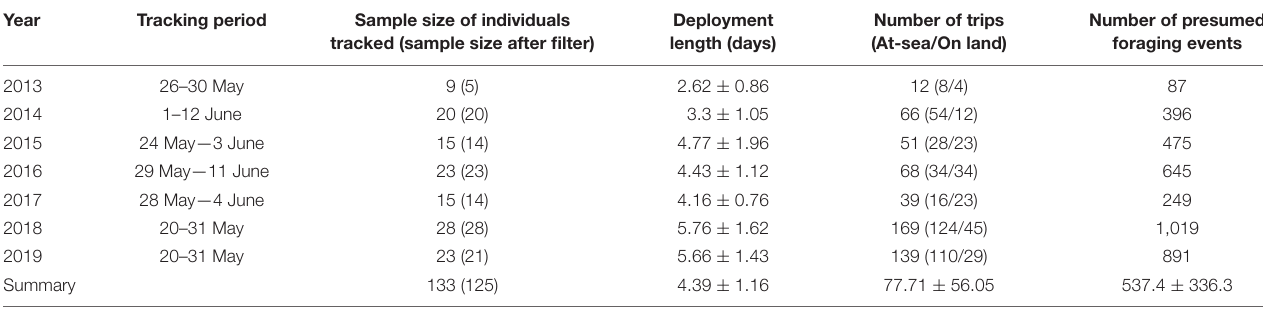
TABLE 1 | Summary of western gull tracking dates, sample size of individuals tracked before and after speed and quality filters were applied, the mean deployment duration, the total number of trips and foraging events by year. Year Tracking period Sample size of individuals Deployment Number of trips tracked (sample size after filter) length (days) (At-sea/On